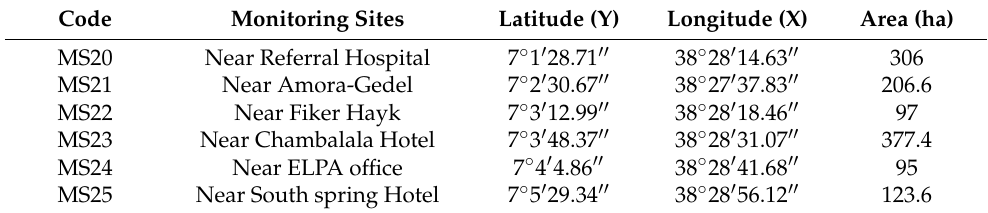
Table 3. Monitoring stations for stormwater from outfalls of drainage system in Hawassa